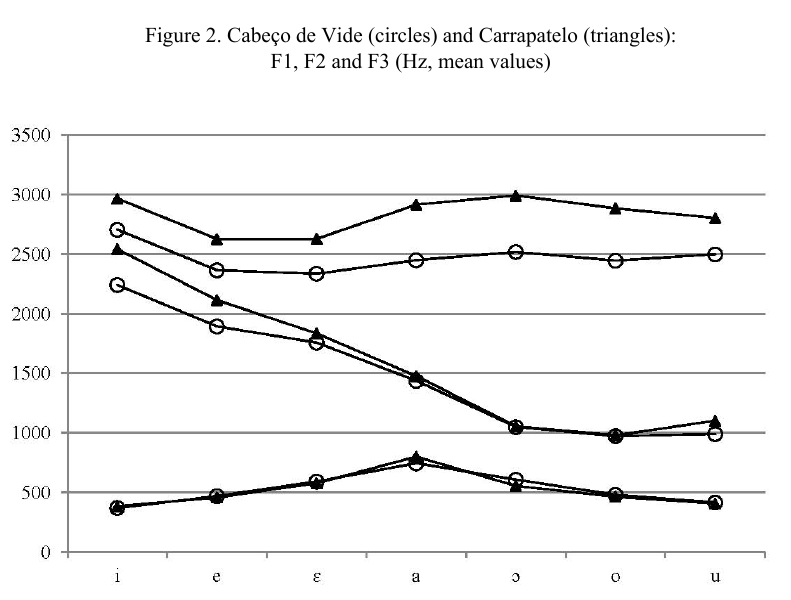
Figure 2. Cabeço de Vide (circles) and Carrapatelo (triangles): F1, F2 and F3 (Hz, mean